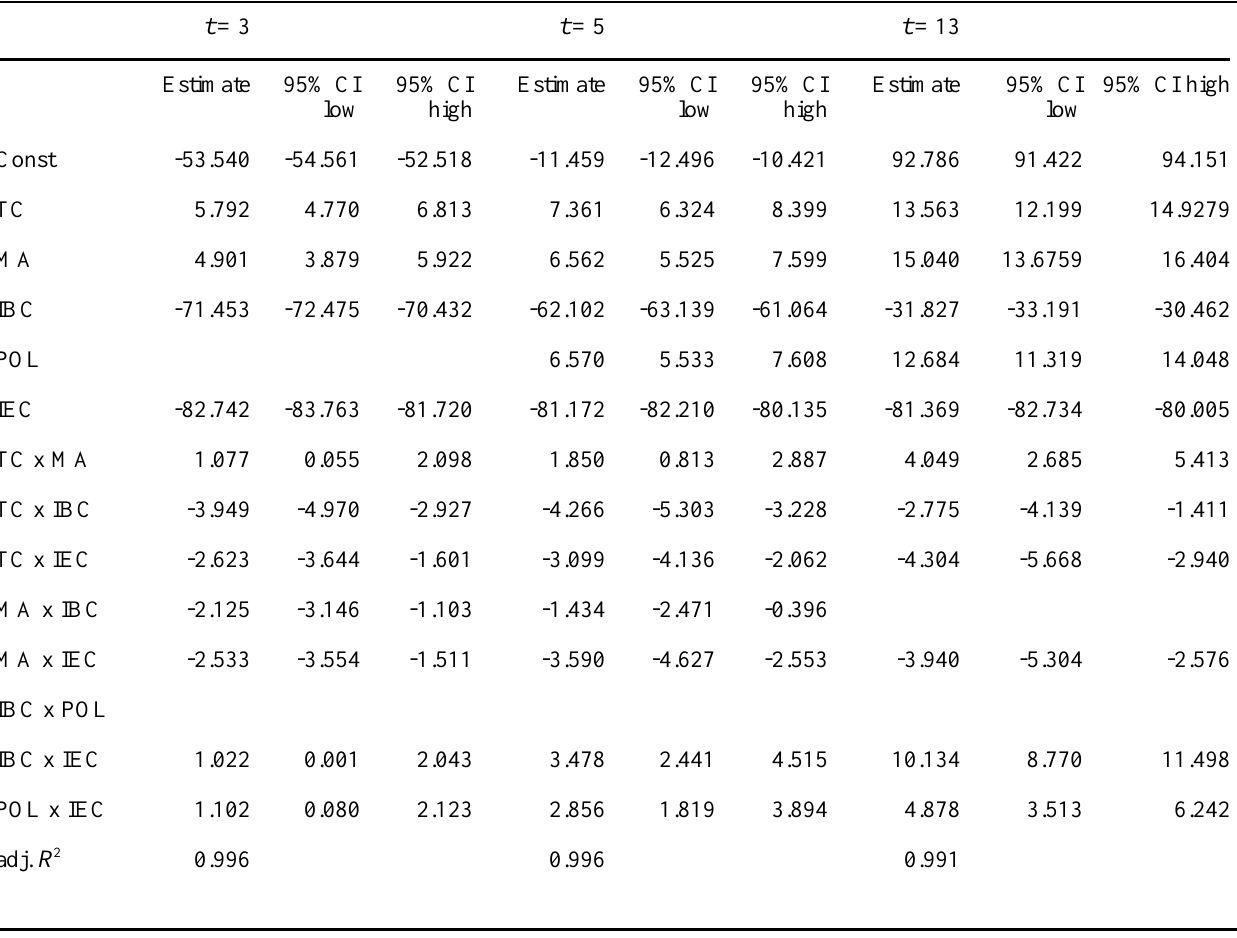
Table 7. Significant factor effects ( P < 0.05) and 95% confidence intervals based on stepwise OLS regression of simulation design for simulation periods t = 3, t = 5, and t = 13. The response variable is the average economic land rent. IBC stands for interest on borrowed capital, IEC stands for interest on equity capital, MA stands for cost savings due to managerial ability, POL stands for the policy scenario, and TC stands for technological